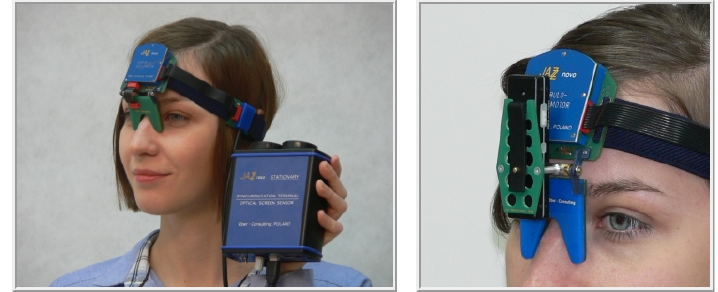
Figure 2. The head-mounted JAZZ-novo eye tracker [30] as used in the research.